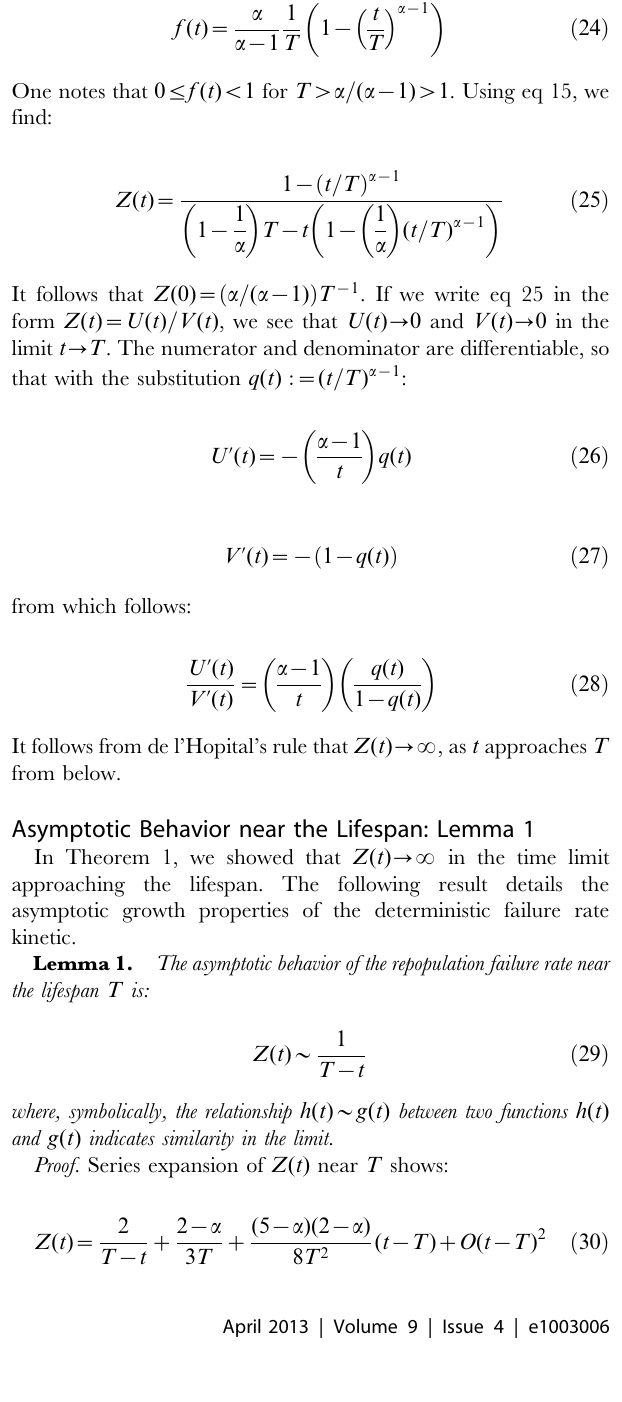
Algorithm 2. Algorithm for calculating the rescaled range statistic and estimating the Hurst exponent H . The notations used are the same as in Algorithm 1. In addition the functions Max() and Min() refer to the maximum or minimum of a data set A respectively. The notation S A T denotes the uniform sample mean of A . The function LinModFit( U * V ) linearly regresses the predictor data V on the response data U with * being used as in the statistical programming language R to express a potential relationship between data. K min w 1 is a minimum lower bound on time series size to conduct meaningful